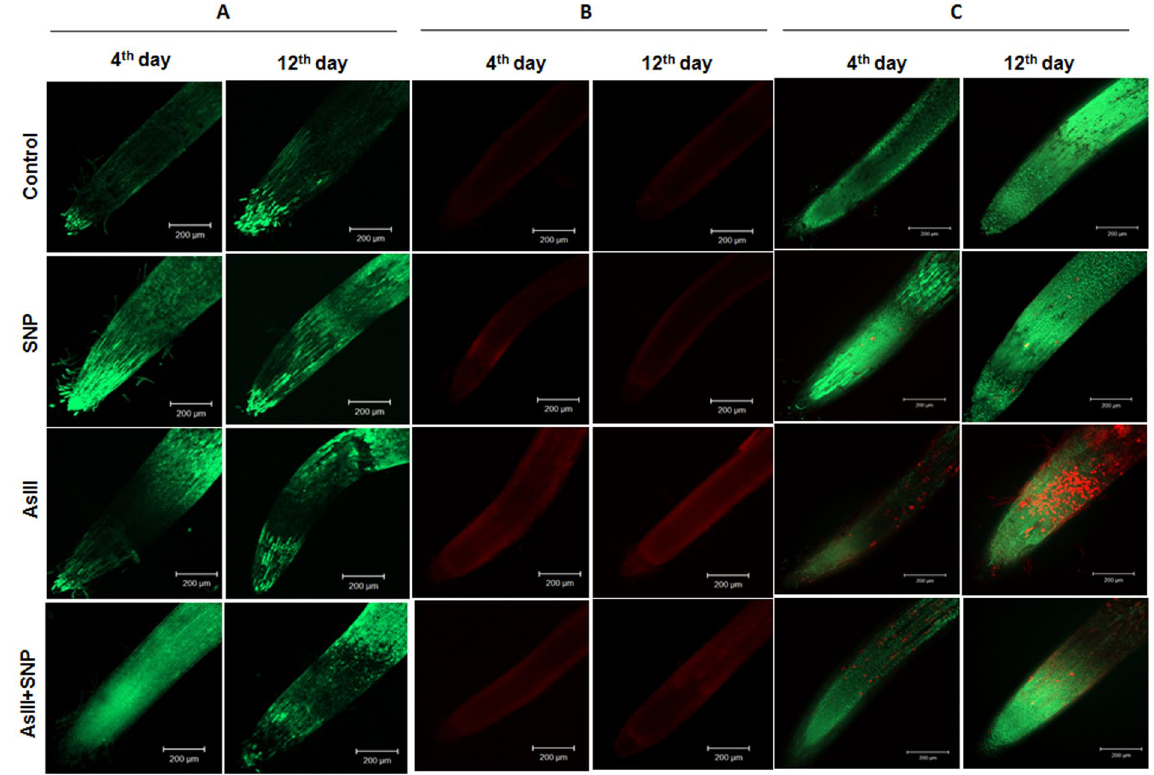
Figure 2. CLSM detection of NO, superoxide and cell viability. Green fluorescence ( A ) represented NO level in different treatments on 4 th and 12 th day. Red fluorescence ( B ) showed superoxide content in various samples at both time intervals. Cell viability ( C ) assay indicated viable and dead cell in green and red fluorescence respectively on 4 th and 12 th day. Results showed higher NO level, cell viability and lower superoxide radical content in the AsIII + SNP treated root as compared to the AsIII treated